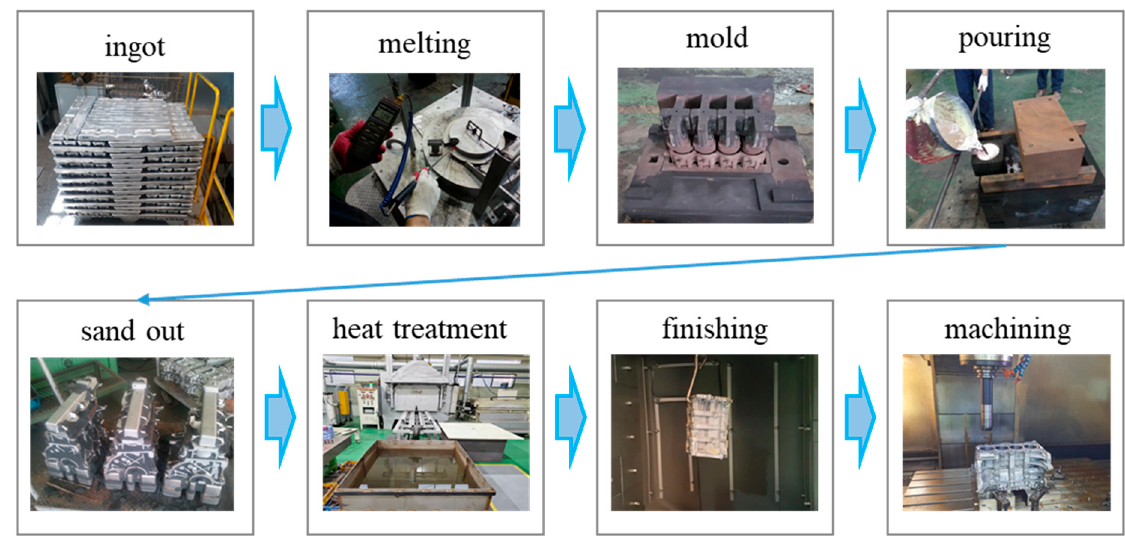
Figure 3. Fabrication of the engine cylinder block through sandcasting.